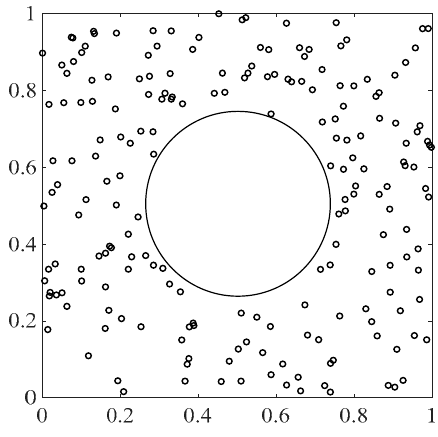
Figure 9. Training samples for 𝒖 . Table 1. Comparison of different noise scales for inversion. Noise